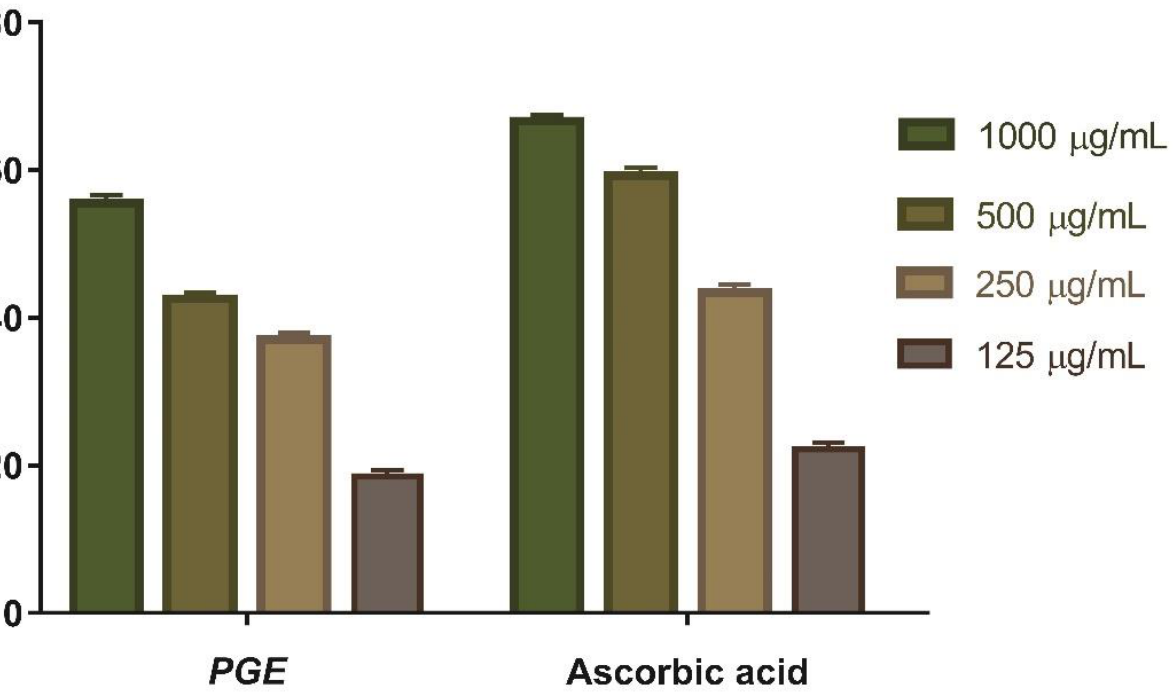
Figure 6. H 2 O 2 radical scavenging activity of PGE at different concentration (1000 µg/mL, 500 µg/mL, 250 µg/mL, and 125 µg/mL). Bars represent mean ± standard deviation (SD). Significant difference between groups is analyzed by a two-way ANOVA test.